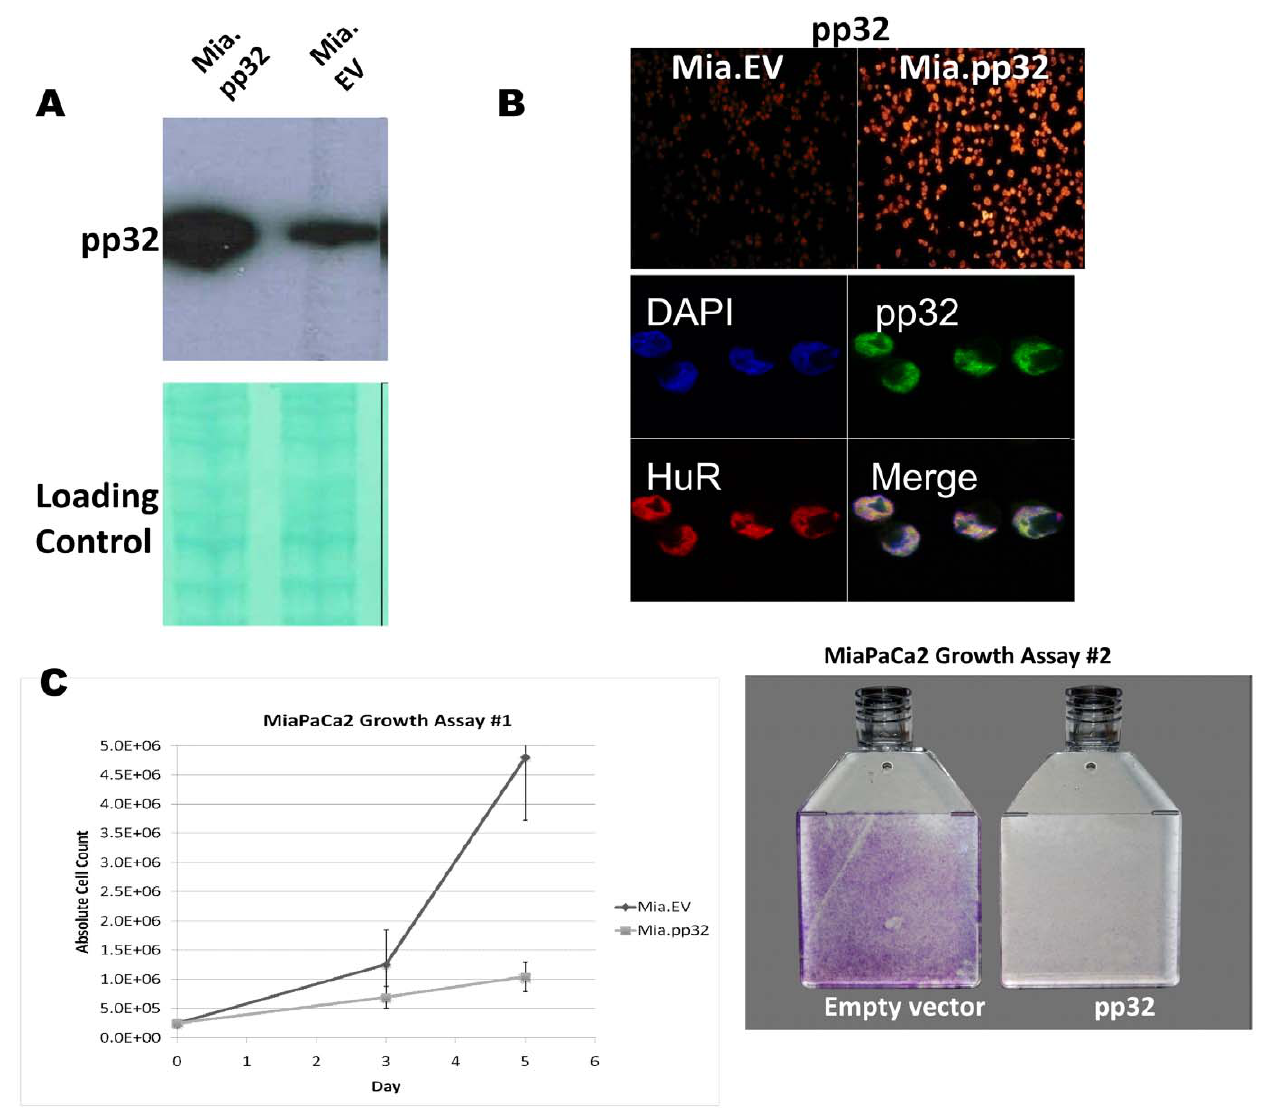
Figure 1. Characterization of pp32-overexpressing cancer cells. (A) Immunoblot analysis of protein lysates from Mia.pp32 cells and controls. Mia.pp32 cells express increased pp32 levels than Mia.EV cells. (B) Immunofluorescence with Mia.pp32 and Mia.EV cells ( top ). Immunofluorescence was also performed with labeling of HuR, pp32, and DAPI under a higher magnification ( bottom ). Cells were then analyzed using laser confocal microscopy. (C) Mia.pp32 cells have significantly reduced growth potential relative to Mia.EV cells. ( Left ) Cells were equally plated and collected on days 3 and 5 and counted. Five-fold fewer Mia.pp32 cells were counted at 5 day compared to Mia.EV cells. ( Right ) MiaPaCa2 cells were transfected with equal amounts of pp32 and empty vector pcDNA 3.1(Zeo). The flasks were treated similarly over a two-week period and subsequently stained with crystal violet to quantitate the number of viable cells (see methods). Each flask is representative of 3 flasks.